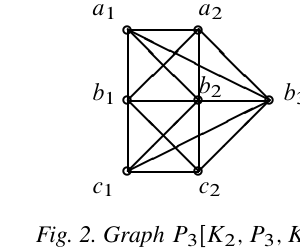
Fig. 1. Graph P 3 ŒP 3 ; K 2 ; K 2 (cid:141) Fig. 2. Graph P 3 ŒK 2 ; P 3 ; K 2